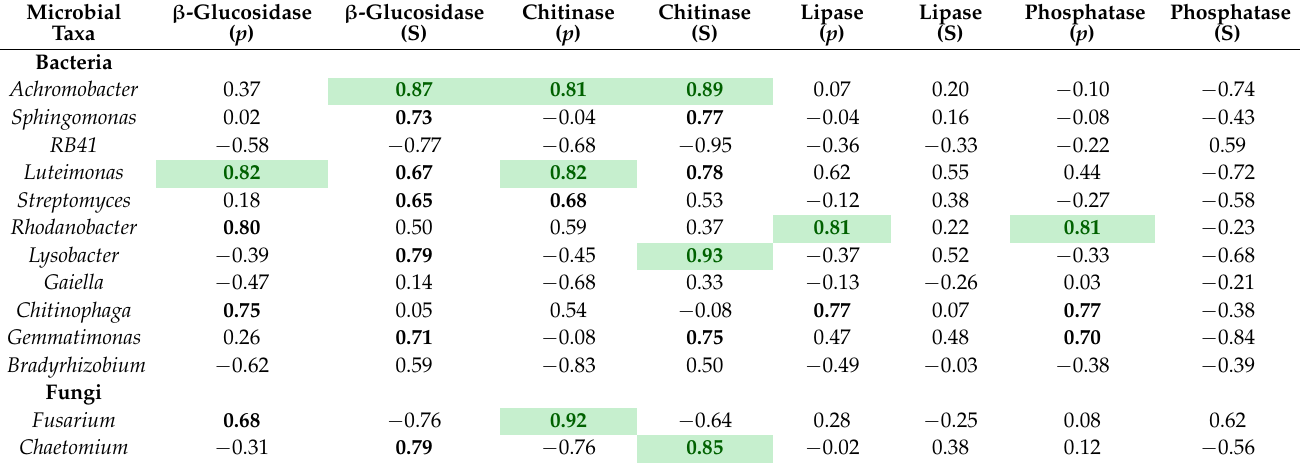
Table 3. Correlations between relative abundances of bacterial and fungal genera with enzyme activities in control (S) and PBSA-added ( p ) soils. Strong positive correlations above ρ > 0.8 are highlighted in green. Bold p values indicate statistically significant correlations p <